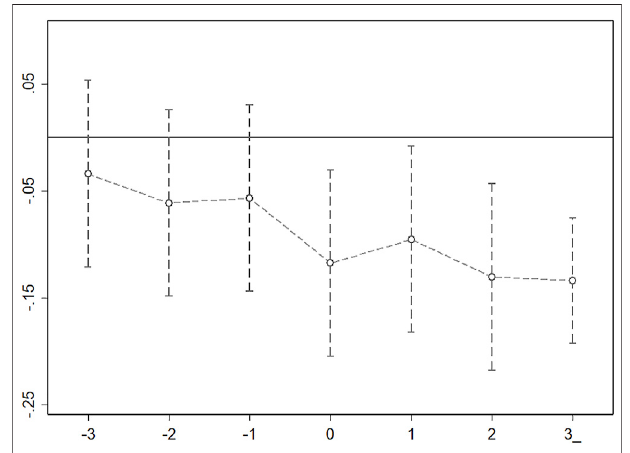
FIGURE 2 | The dynamic effect of the ETP on fi rms ’ labor demand. FIGURE 3 | Placebo